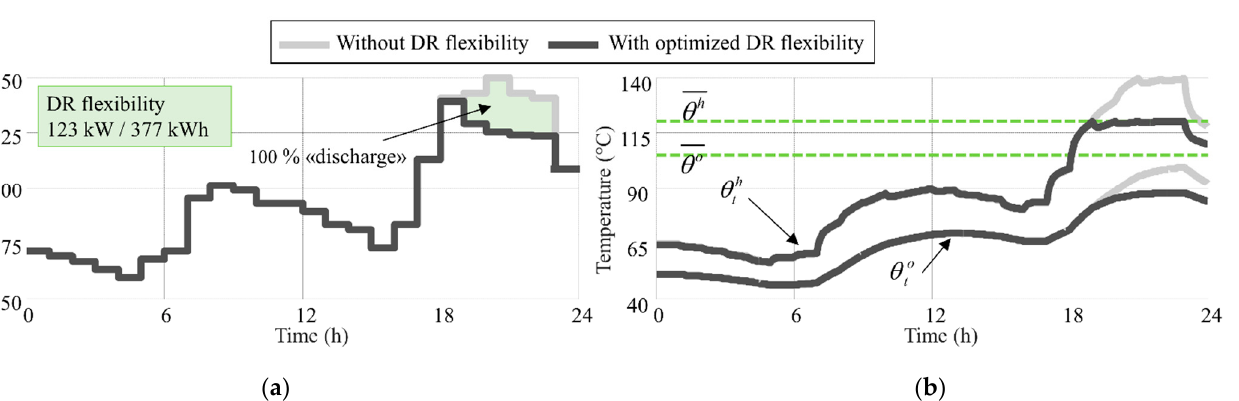
Figure 11. Validation run with “energy shedding”: ( a ) transformer loadings; ( b ) temperatures.